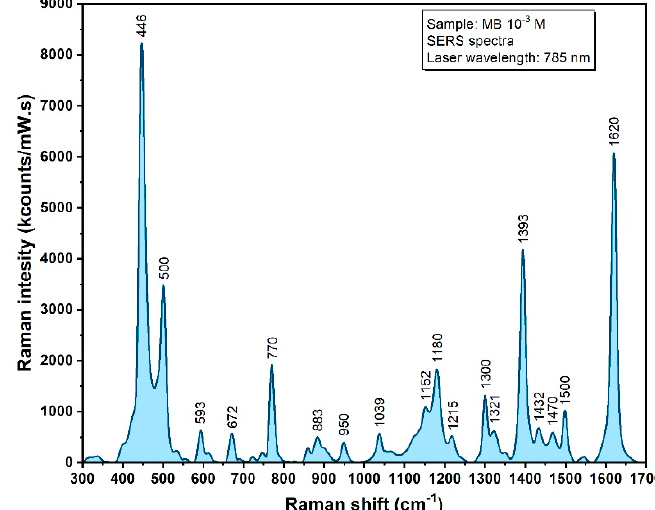
Figure 4. SERS spectrum of a dried solution of Methylene Blue (MB, 1 mM) recorded using a 785 nm excitation